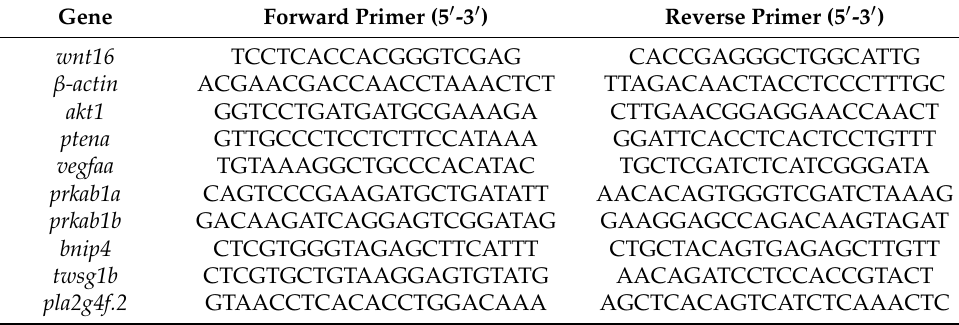
Table 2. The primer sequences of the down-regulated genes and wnt16 of qRT-PCR.